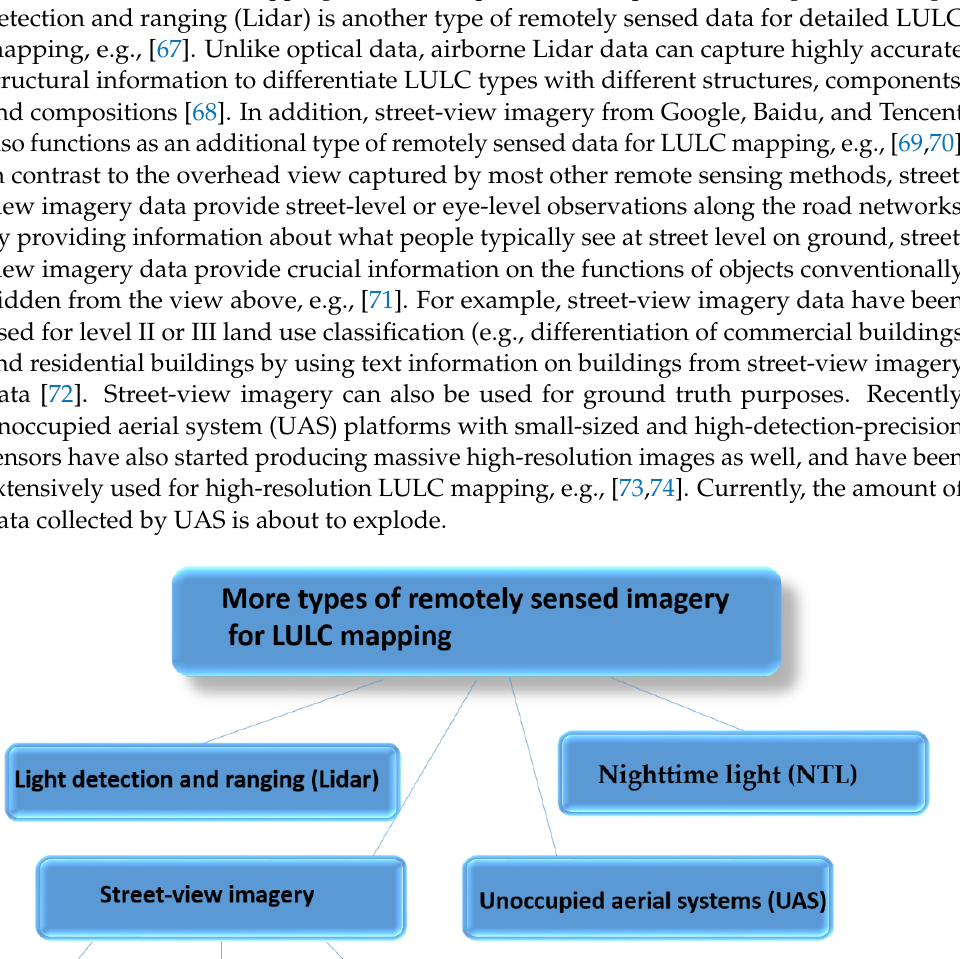
Figure 2. Different types of remotely sensed satellite imagery for LULC mapping.